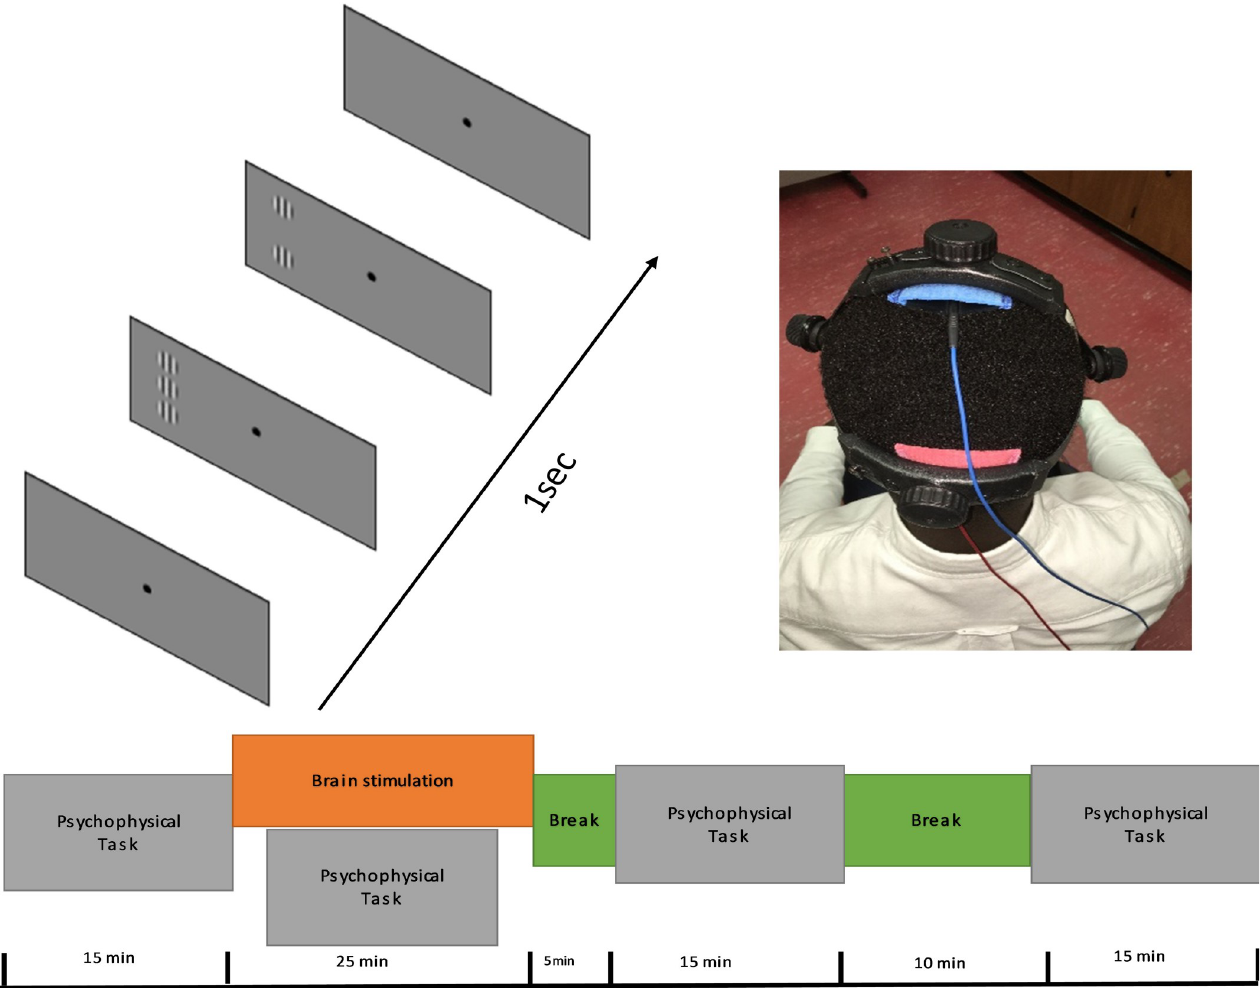
Fig 1. Experimental design. A) Collinear configuration of Gabor patches that has the same orientation and phase. B) Sample picture of a participant wearing the eye tracker and the electrodes of tDCS secured using the head strap of the eye tracker. C) Timeline of the experiment. The same timeline was used for anodal and sham